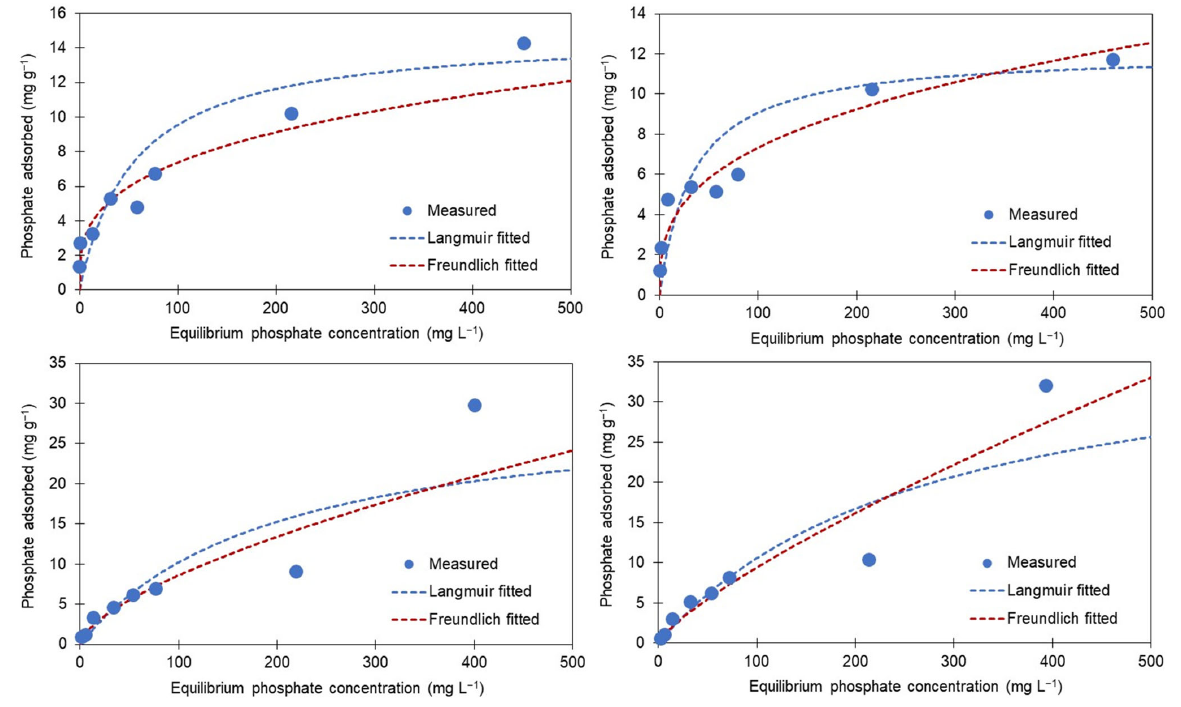
Figure 6. Phosphate adsorption isotherm fitted with the Langmuir and Freundlich models. Table 3. Adsorption parameters estimated from the Langmuir and Freundlich adsorption models.